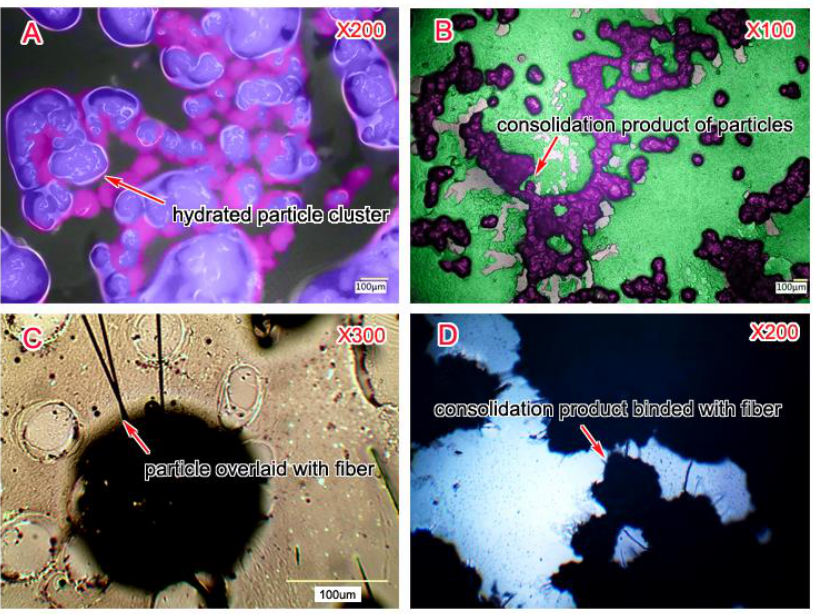
Figure 4. Morphology of a particulate cluster and the dispersed solid of the composite pressure-activated sealant. ( A ) Hydrated particulate clusters with the hydrated layer are marked in purple. ( B ) Consolidation of the coalescence particulates formed by the dehydration. ( C ) A single particle that is overlain with fiber. ( D ) Cross section image of the consolidation product.